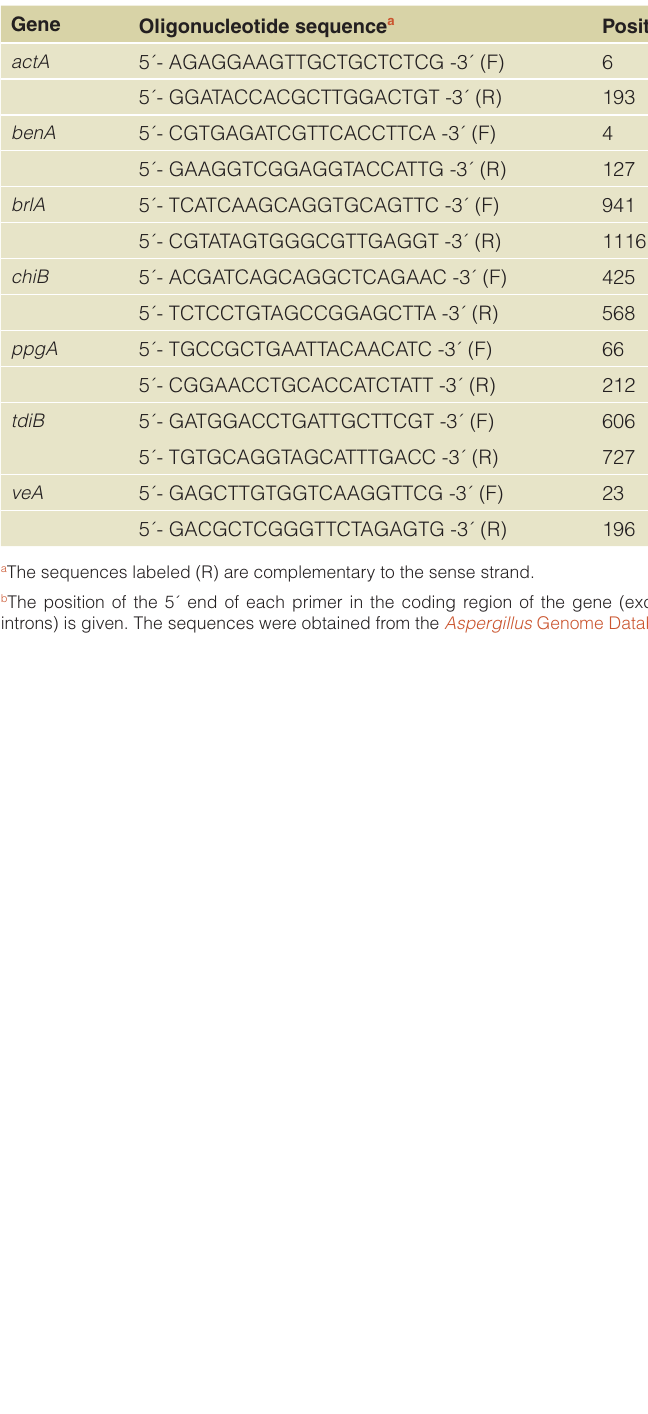
Supplementary Table 1. Oligonucleotides used in qRT-PCR